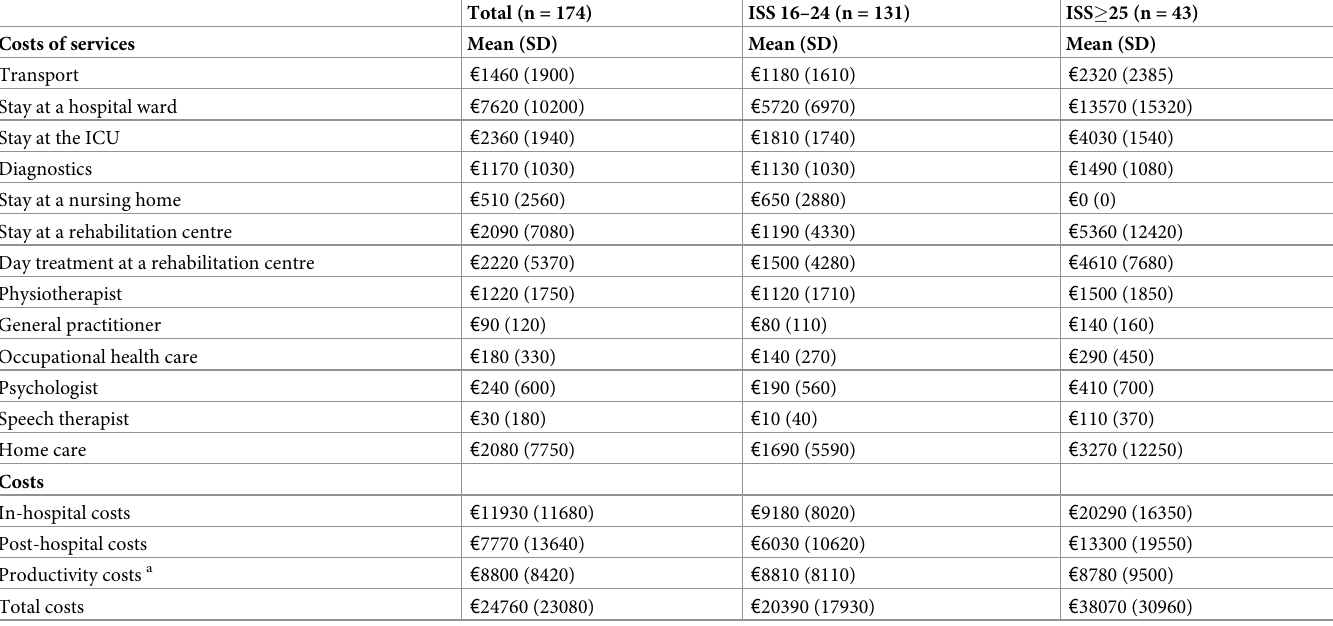
Table 3. Mean (SD) costs by category of service and total health care and productivity costs of adult trauma patients (ISS �